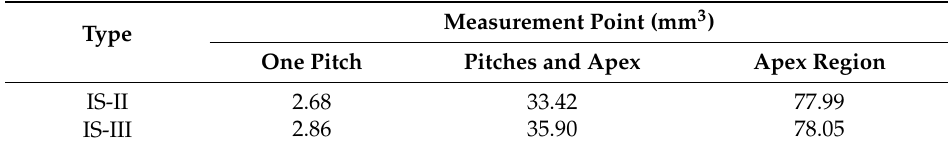
Table 4. The values of overall volume, one pitch volume, and cancellous bone volume at the apex of the fixture for IS-II and